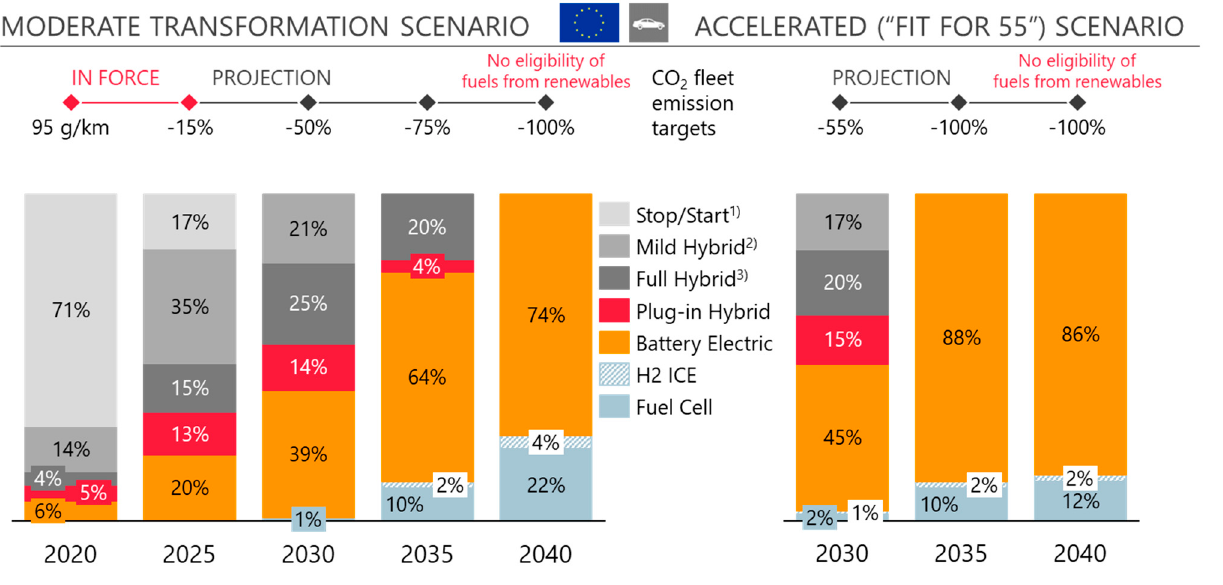
Figure 1. Future development of passenger car powertrain topology in Europe (2020–2040) [3]. 1) Stop/Start and 12 V energy management. 2) 12 V and 28 V mild hybrids. 3) Includes 48 V hybrid with fully hybrid functionalities.